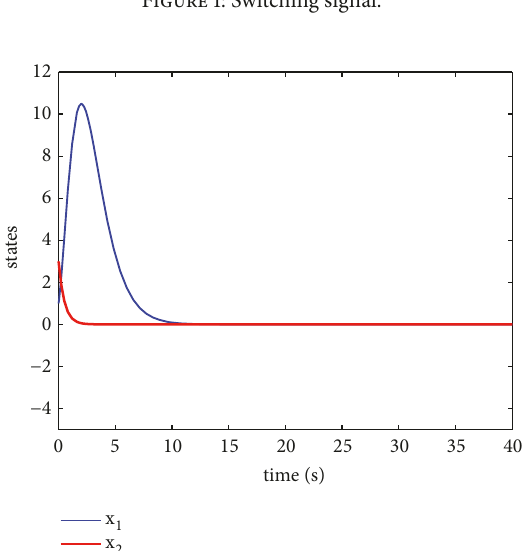
Figure 1: Switching signal.